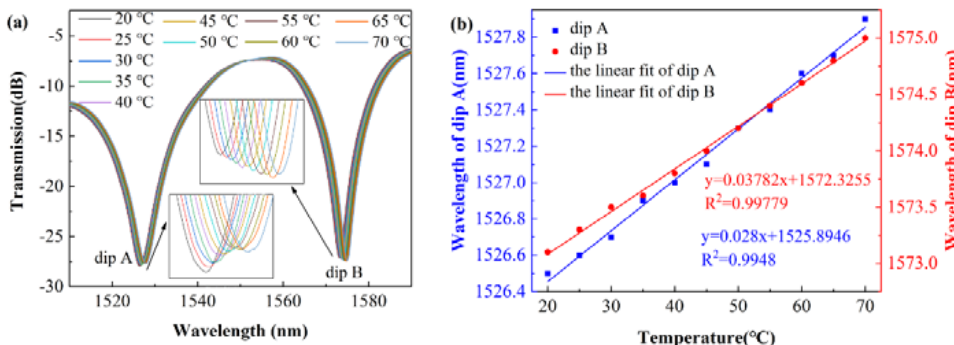
Figure 13. ( a ) Transmitted spectra of the SCSHF sensor under different temperatures; ( b ) linear fiting curve between dip wavelength and temperature.